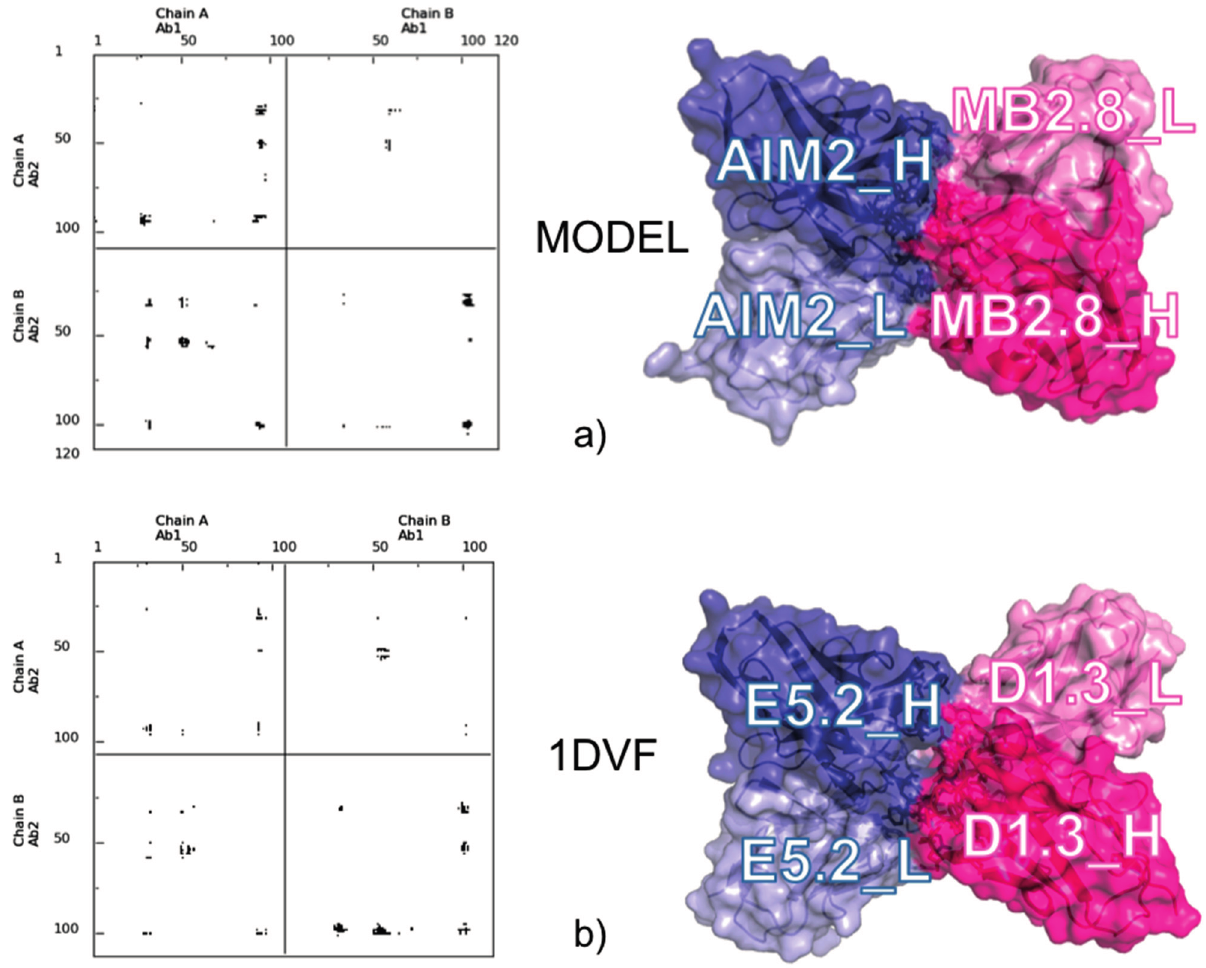
Figure 3. Comparison between the selected docking model for the MB2.8-AIM2 complex and the X-ray structure of the D1.3-E5.2 Ab1-Ab2 complex (1DVF [41]). ( a ) Contact map ( left ) and surface representation ( right ) of MB2.8-AIM2; and ( b ) contact map ( left ) and surface representation ( right ) of D1.3-E5.2. Labels have been added for the Ab1’s and Ab2’s light and heavy